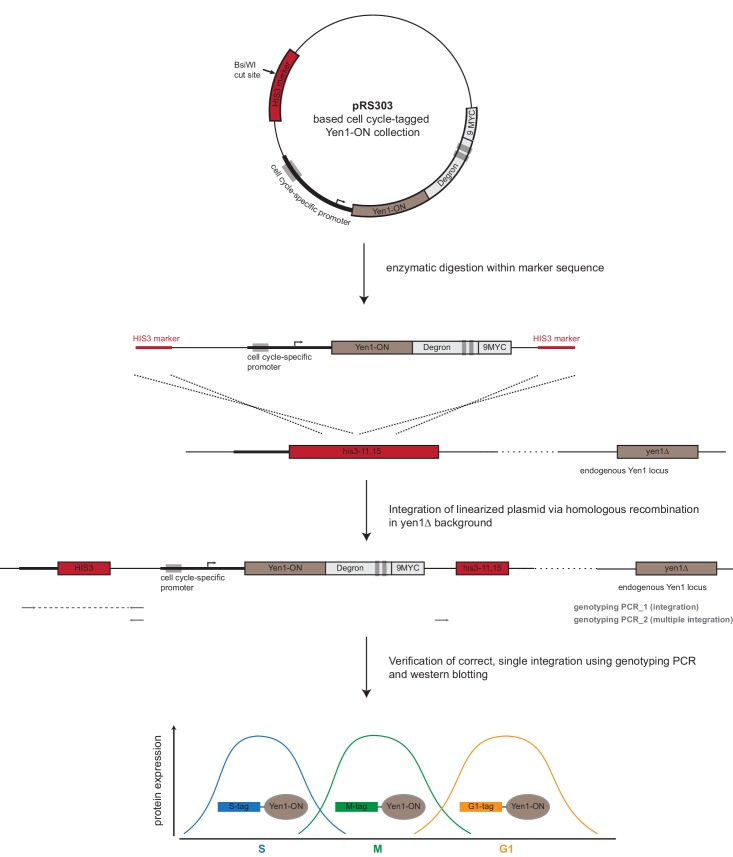
Strategy for C-terminal cell cycle tagging of Yen1-ON.In order to generate Yen1-ON alleles expressed under cell cycle-regulated promoters and with C-terminal degrons, Yen1-ON constructs were generated in pRS303 integrative vectors. Cell cycle-tagged Yen1-ON constructs were linearized and integrated at the his3-11,15 locus via homologous recombination. A detailed description of the workflow can be found in Materials and methods (construction of cell cycle-tagged strains).